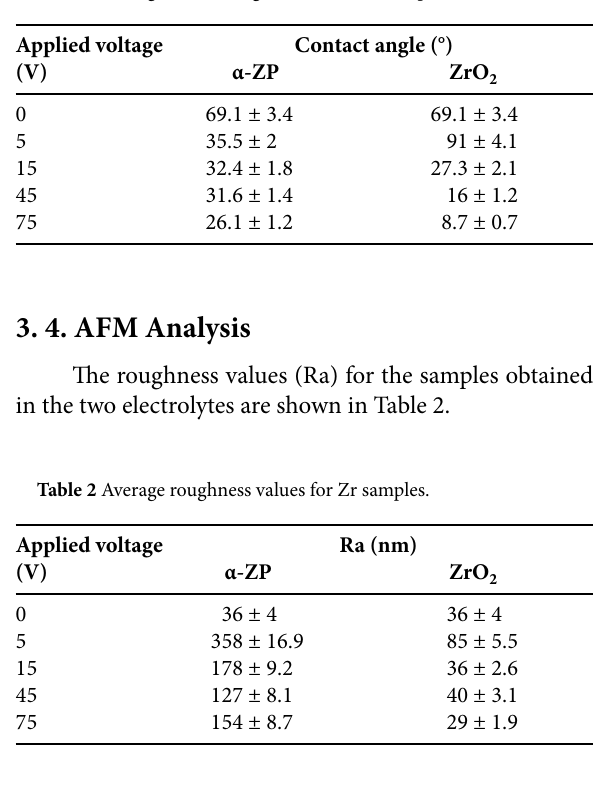
Table 1 Average contact angle values for Zr samples.